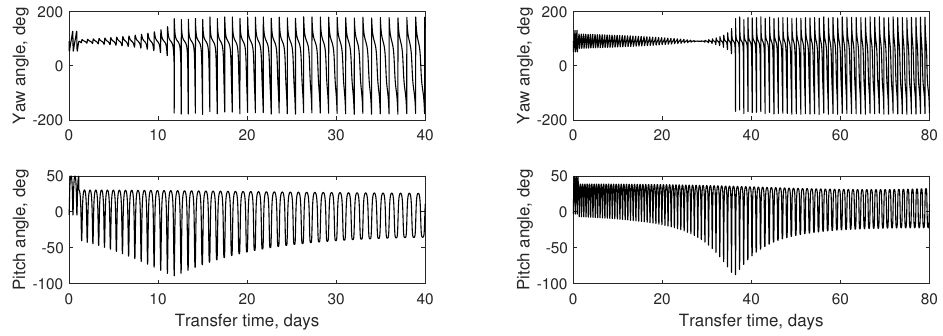
Figure 5. The time histories of thrust direction angles with transfer time of 40 days and 80